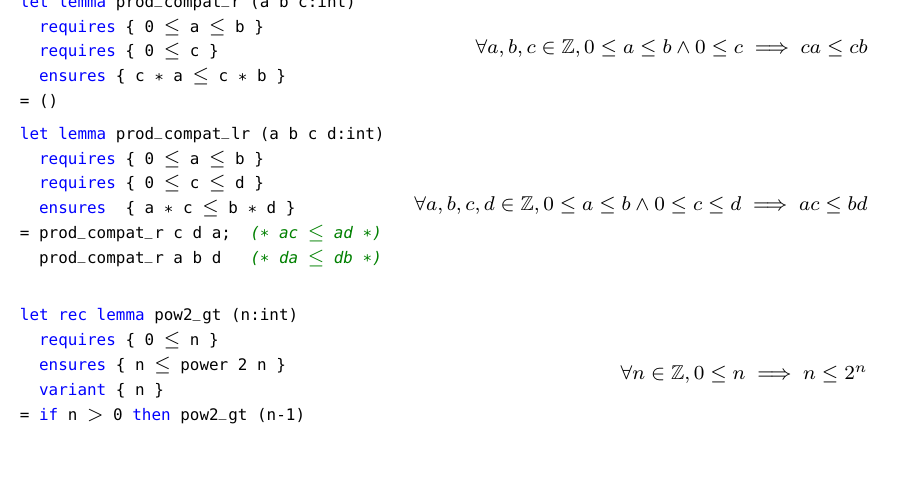
Fig. 5. Declaring, proving and using